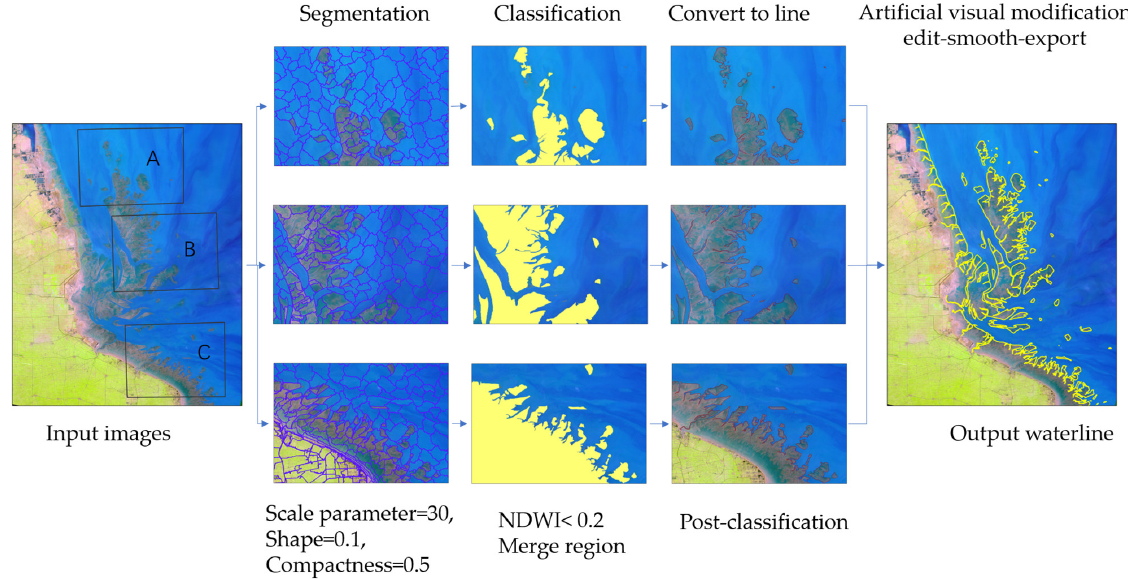
Figure 3. Waterline extraction flow diagram using the object-oriented classification